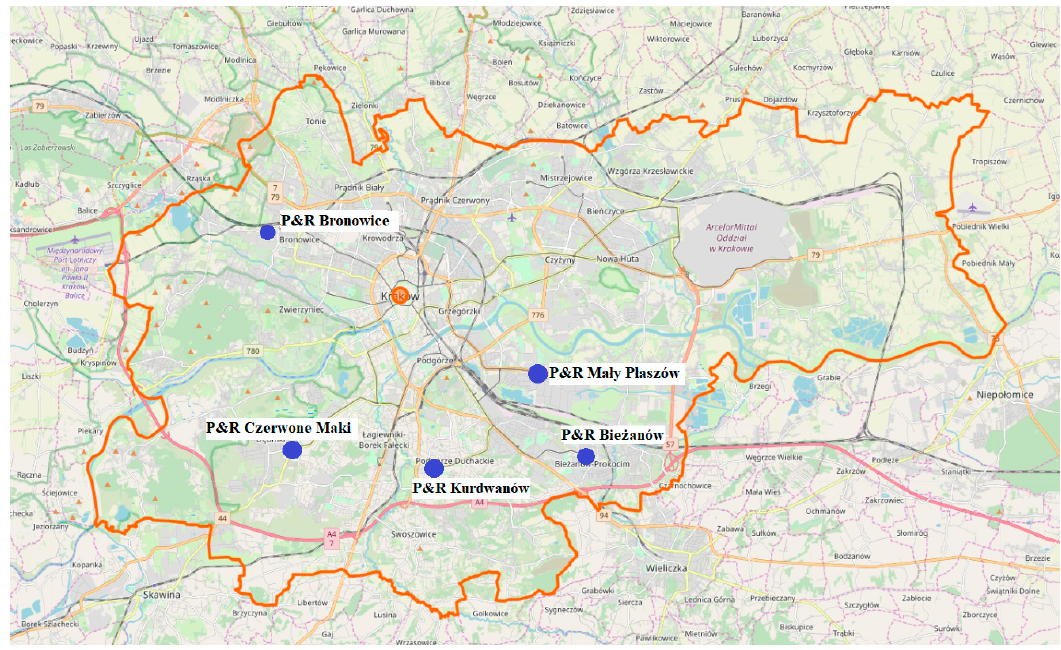
Figure 2. P&R parking localization on the background of the city of Cracow. Source: The authors, based on [53].